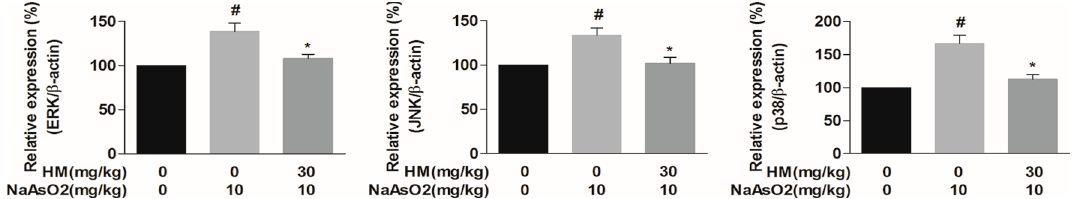
Figure 5. HM attenuated the gene expression of mitogen-activated protein kinase (MAPK) (extracellular signal-regulated kinases ( ERK ), C-Jun N-terminal kinases ( JNK ), and p38 ) in liver tissue. The expression level of MAPK genes was significantly upregulated in NaAsO 2 -exposed liver tissue, but co-treatment with HM effectively downregulated the gene expression. Data are expressed as mean ± standard error mean (SEM) of three independent experiments. # p < 0.05 compared with the control and NaAsO 2 group, and * p < 0.05 compared with the NaAsO 2 and HM extract-treated group.